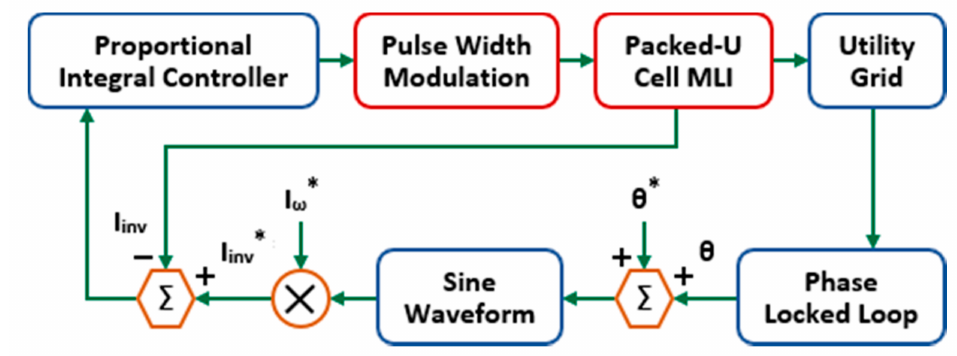
Figure 27. Block diagram of a single phase grid connected packed U-cell based MLI.